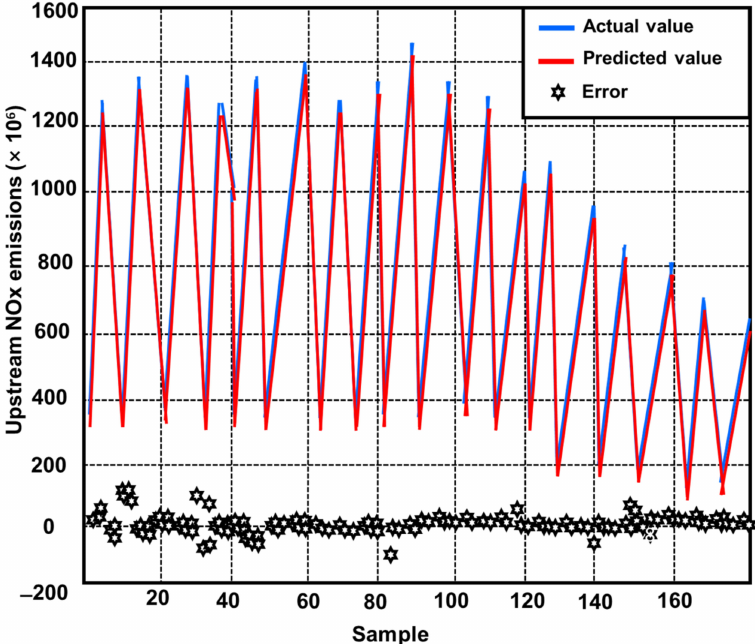
Figure 22. Comparison of experimental and projected NOx emissions from actual production against predicted output upstream sources